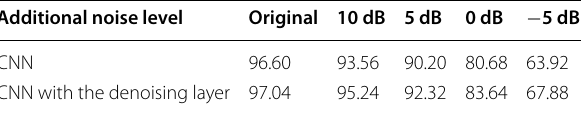
Table 3 Classification accuracy of the CNN based experiment (%) Additional noise level